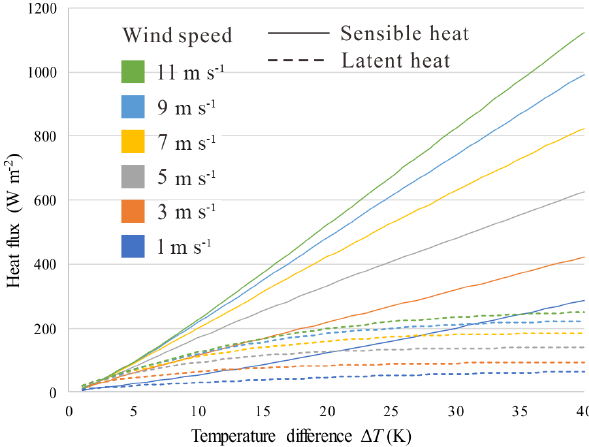
Figure 3. Turbulent heat flux rises with increasing temperature dif- ference (cid:49)T and intense wind at lead width of 30m. Solid and dashed lines represent sensible and latent heat, respectively. Wind speed is illustrated by line color. Clearly, sensible heat flux is basi- cally proportional to (cid:49)T .